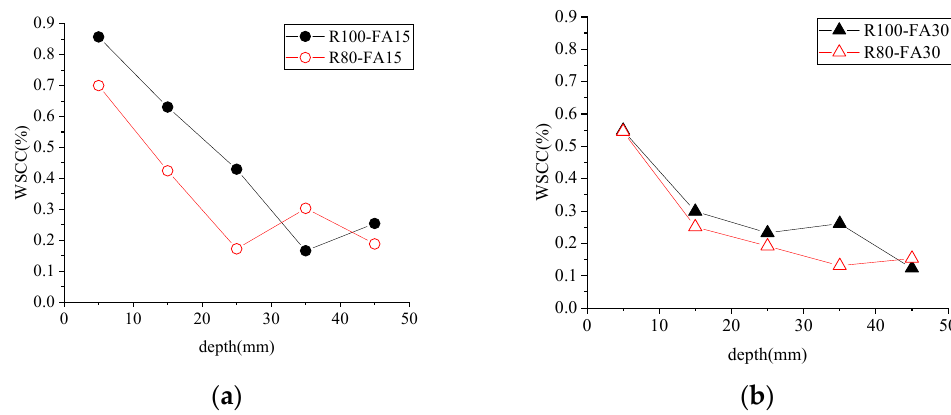
Figure 10. Influence of aggregate replacement rate on WSCC. ( a ) FA15, ( b ) FA30. Note- FA is for fly ash; numbers are the value of replacement rate (%).